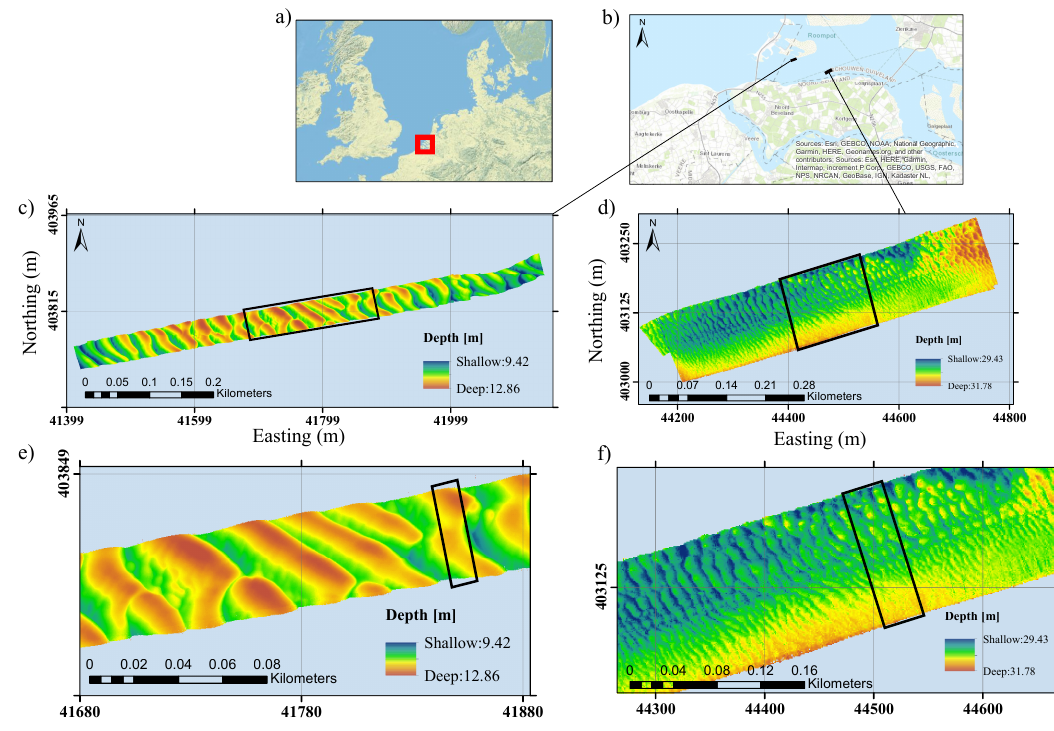
Figure 1. Study areas: ( a ) the North Sea and ( b ) southwest of The Netherlands showing the Oosterschelde estuary (Eastern Scheldt) and the location of the two datasets. Bathymetry maps of the surveyed area for ( c ) a 10m water depth with the grid cell size of 0.25m × 0.25m, ( d ) a 30m water depth with the grid cell size of 1m × 1m, ( e ) zoomed in on the black rectangle shown in ( c ), and ( f ) zoomed in on the black rectangle shown in ( d ). The bathymetry maps correspond to the measurements with a pulse length of 54µs. The black rectangles in ( e , f ) indicate the areas considered for the depth uncertainty